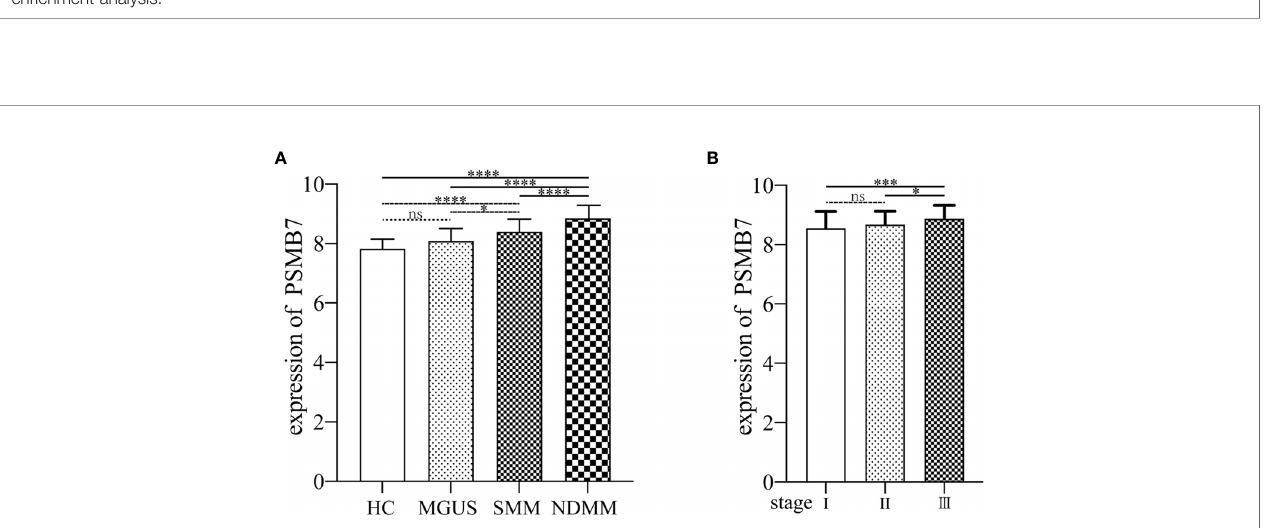
FIGURE 4 | The expression of PSMB7. (A) The expression of PSMB7 from HC to NDMM in GSE6477. (B) The expression of PSMB7 in different ISS status in E-MTAB-4032. ns, not signi fi cant, * P < 0.05, *** P < 0.001, and **** P <